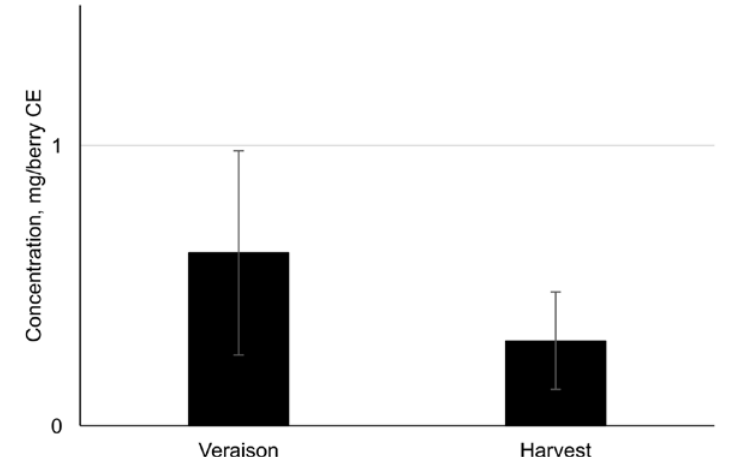
Figure 2. Summary statistics of mean values from the analysis of total tannin concentration (i.e., sum of tannin concentration extracted from skins and seeds) at veraison and harvest. Bars indicate the standard deviation.